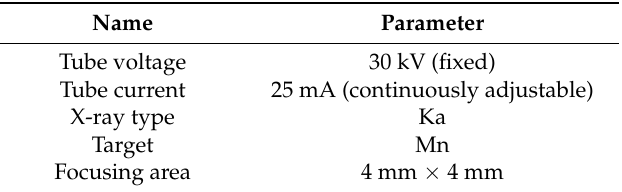
Table 3. Main parameters of the X-ray stress analyzer.